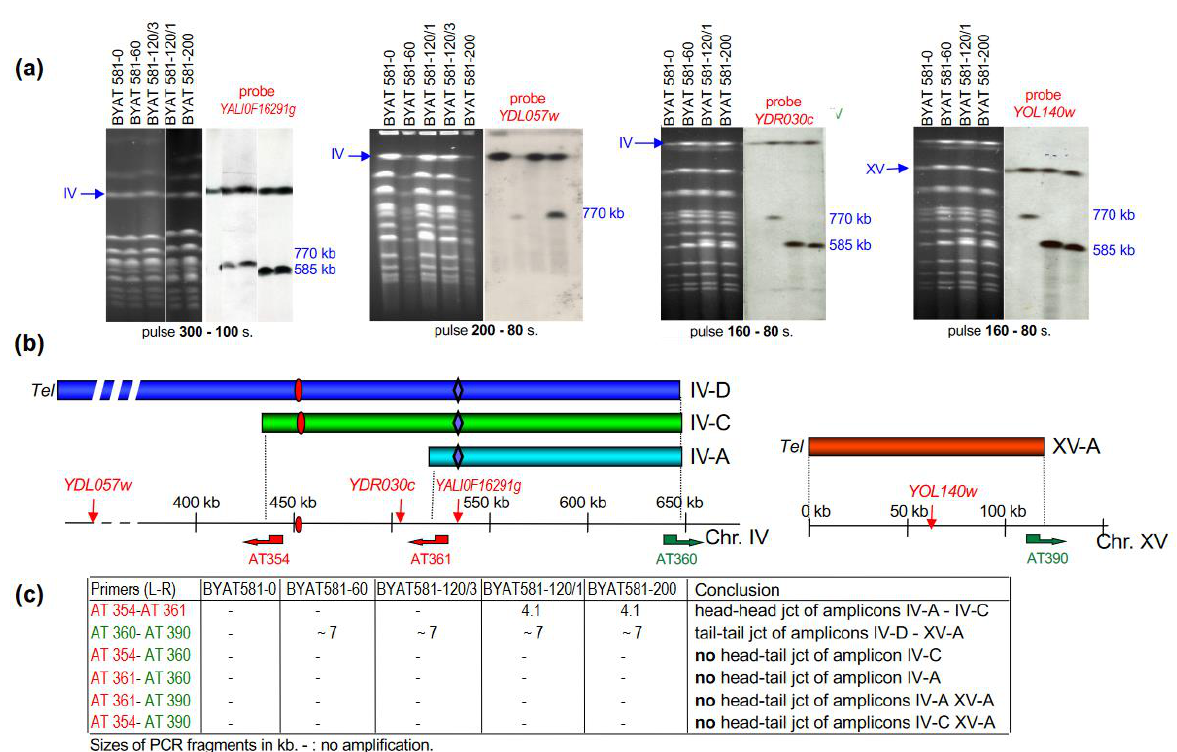
Figure 3. Chromosome structures of evolved mutants as determined by PFGE and PCR amplifications at amplicon junctions. ( a ): Results of pulsed-field gel electrophoreses hybridized with indicated genes as probes. Note the different order of samples in the different panels. ( b ): Schematic locations of probes (thin vertical arrows) and primers (thick horizontal arrows pointing leftward or rightward to indicate orientation) along chromosomal regions of amplicons (horizontal color bars). Sequences, orientations and positions of primers are indicated in Supplement Table S1. ( c ): Results of PCR amplifications using indicated primers on total DNA from indicated strains. Sizes of amplified fragments are indicated in kb.—no amplification.